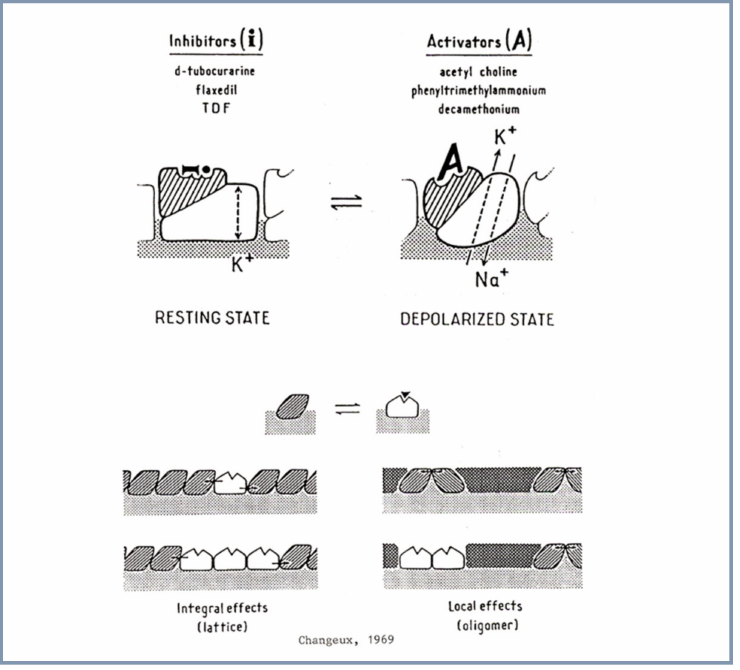
Figure 1. Diagrammatic representation of the then plausible extension of the model of allosteric interaction to the nAChR (reproduced from